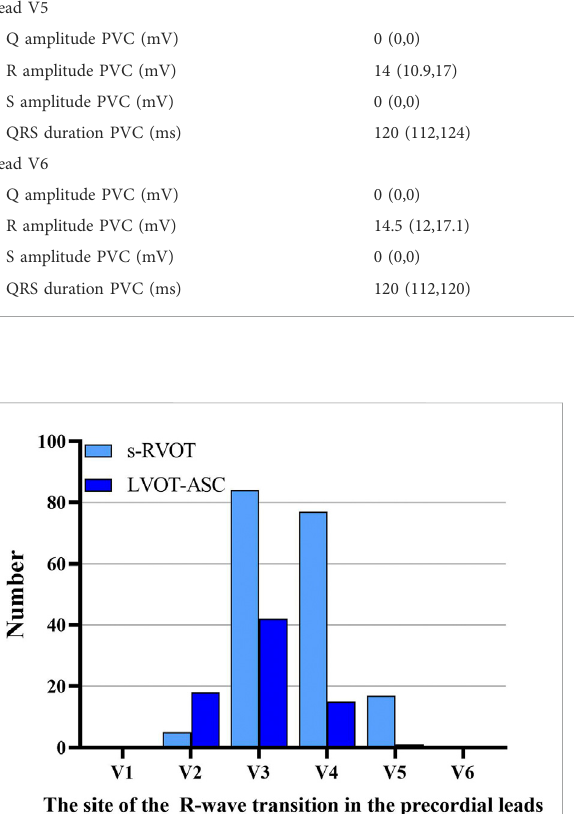
FIGURE 1 Sites of the R-wave transitions in the precordial leads in the s-RVOT and LVOT-ASC groups.